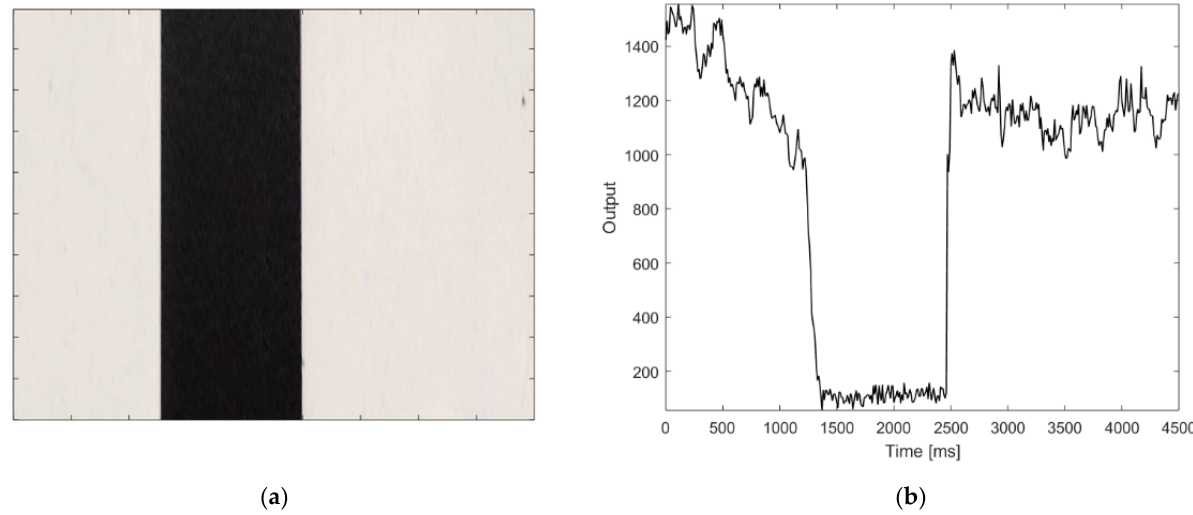
Figure 9. A pplication of the proposed sensor as remote optical encoder. (a ) Code scale realized by a black tape and ( b ) the Figure 9. Application of the proposed sensor as remote optical encoder. ( a ) Code scale realized by a black tape and ( b ) the response of the sensor regarding the code scale measured at a distance of 6 m. response of the sensor regarding the code scale measured at a distance of 6 m.